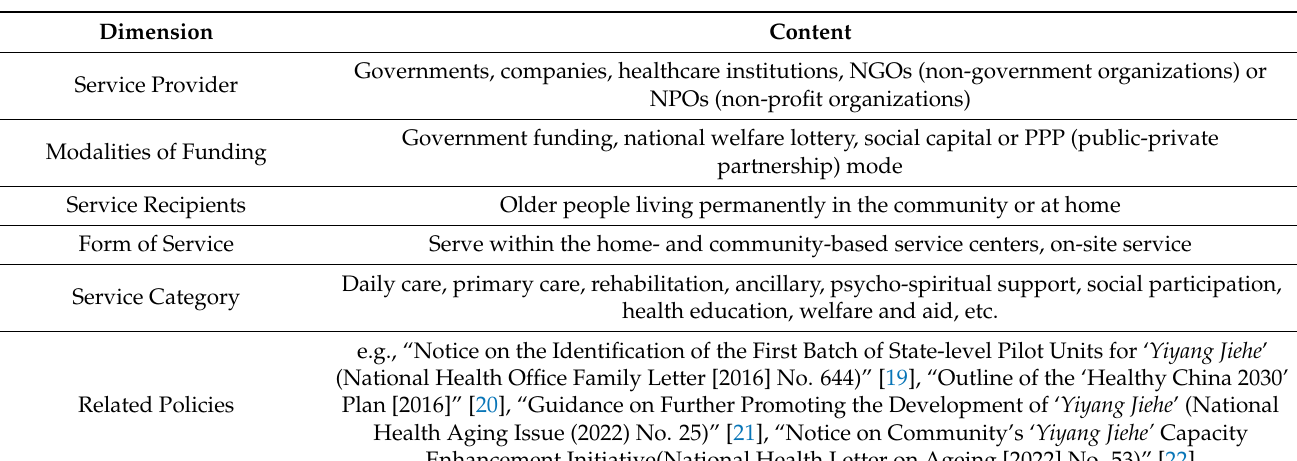
Table 1. Description of the CBAS integrated with medical care in